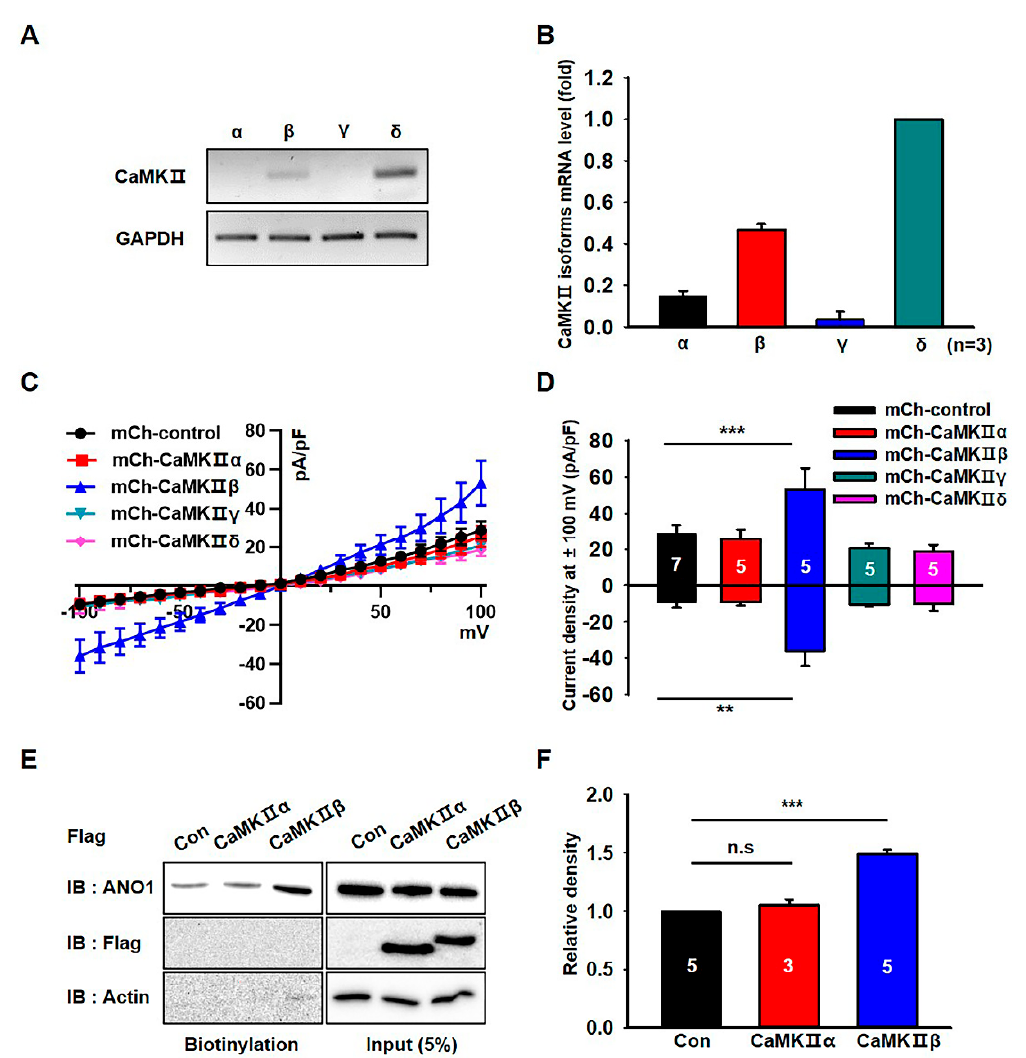
Figure 3. CaMKII β specifically increases the surface expression and activity of ANO1 in U251 cells. ( A ) The mRNA expression of CaMKII isoforms in U251 cells were detected with specific primers for CaMKII α , β , γ and δ . ( B ) Normalized expression of CaMKII isoforms as compared to that of GAPDH in U251 cells. ( C ) E ff ect of CaMKII isoform overexpression on ANO1-mediated whole cell chloride currents in U251 cells. ( D ) The summary bar graph showing ANO1-mediated current density at ± 100 mV. ( E ) Cell surface biotinylation results from membrane protein fractions from U251 cells transfected with mCh-CaMKII α and mCh-CaMKII β . ( F ) The summary bar graph showing data obtained from at least three independent experiments as in ( E ). Number on each bar indicates n for each condition. All values are mean ± s.e.m. P -values were obtained with Student’s t-test. ** p < 0.01 and *** p < 0.001. n.s means not